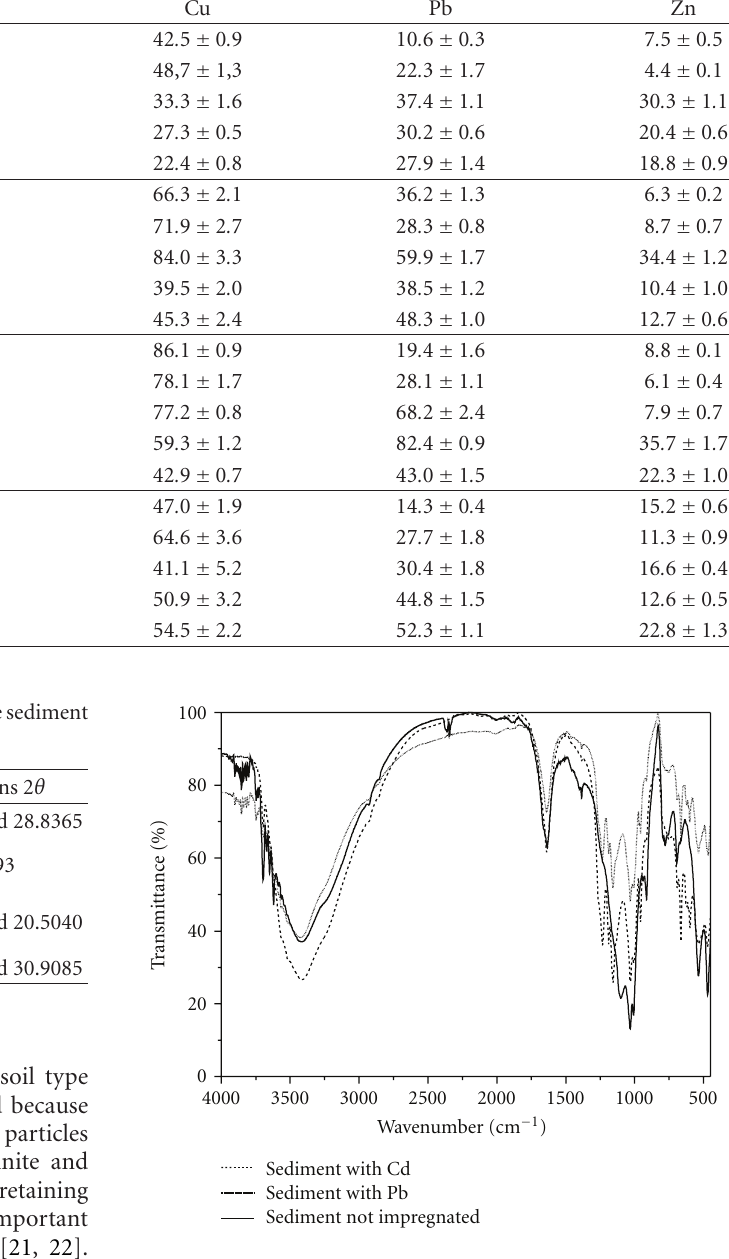
Figure 8: Infrared spectrum of the sediment sample collected at point 5 (March of 2007). Black and continous line is related to sediment not impregnated, while gray and continous line is related to sediment with